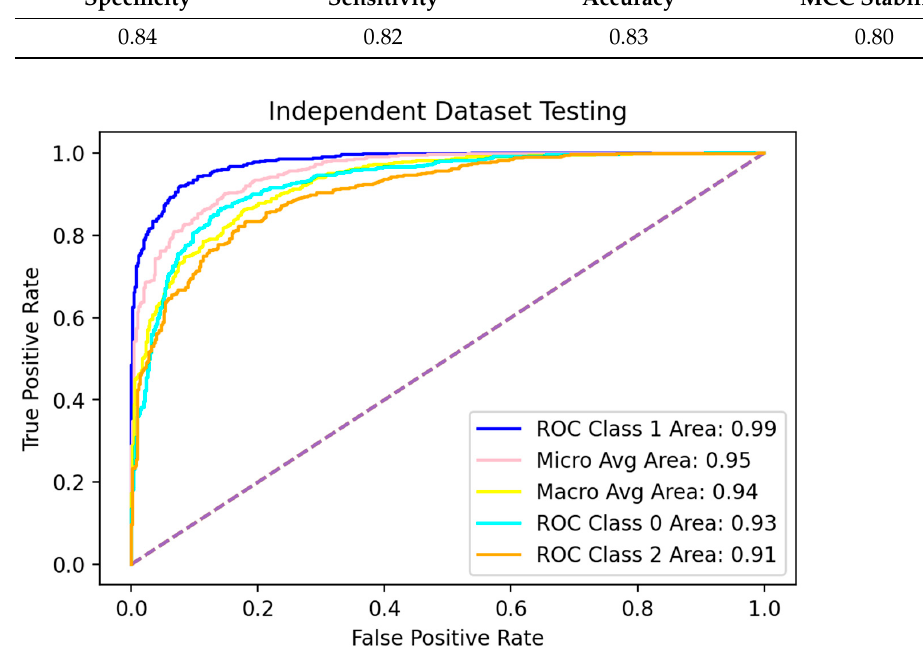
Figure 7. ROC curve of independent dataset test.